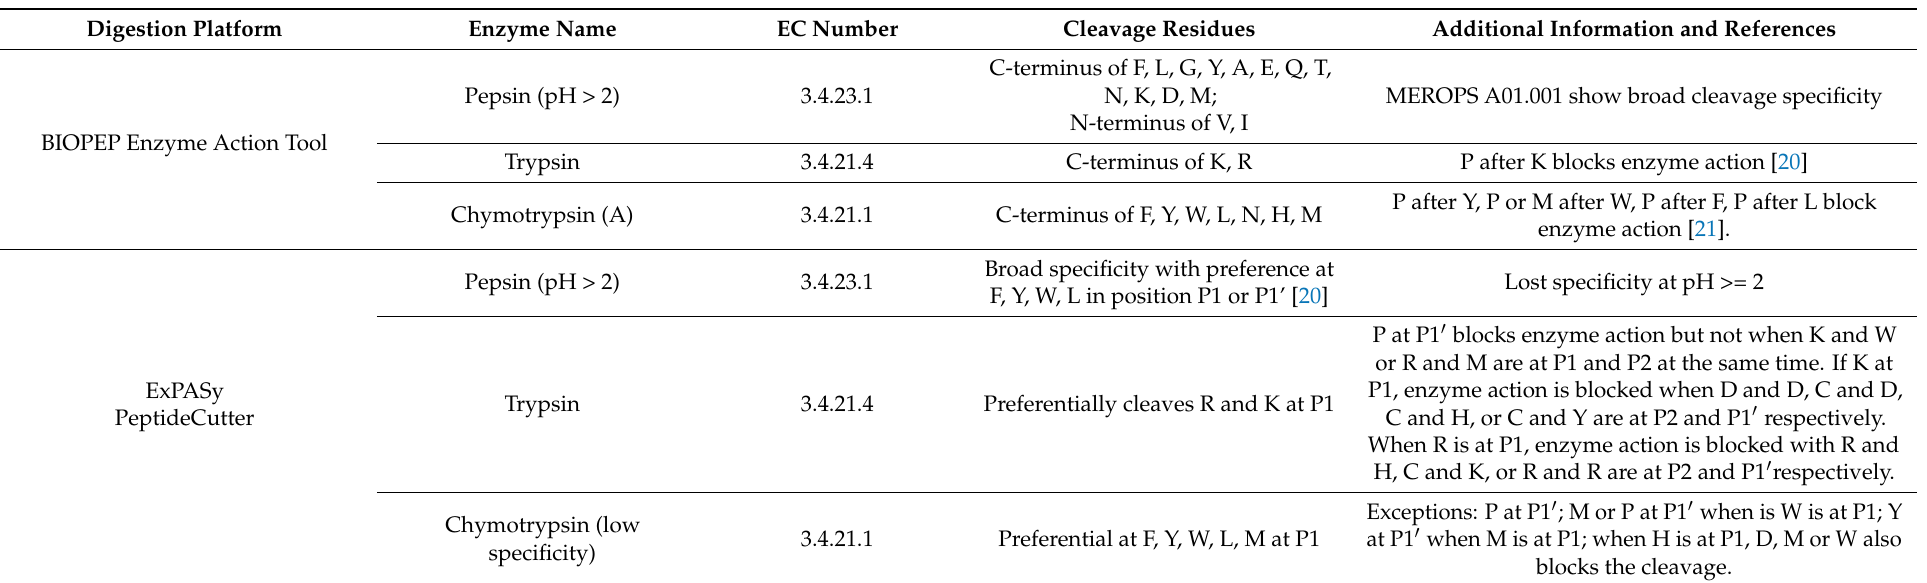
Table 1. Digestive enzyme selection in BIOPEP and ExPASy